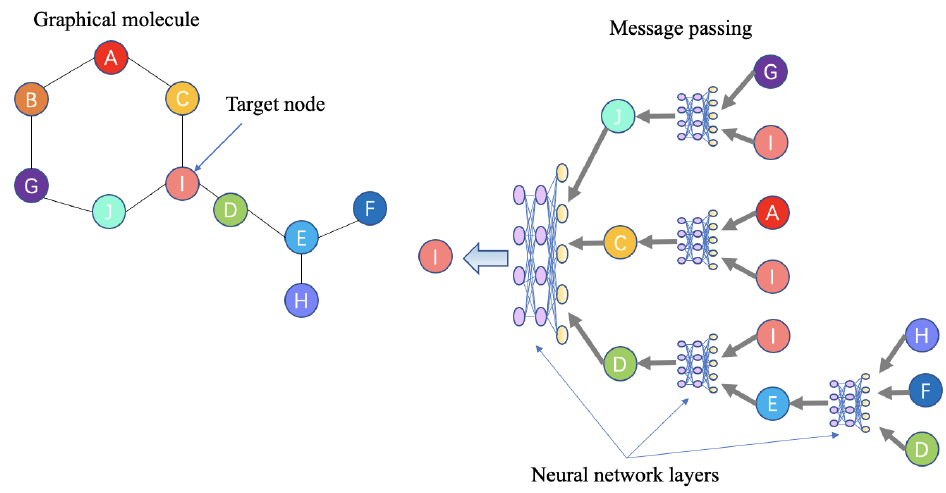
Figure 4. Example of a message passing neural network. The left side is an example of a graphical molecule. Ten atoms are regarded as nodes, with each node connecting with one or more nodes. The right side shows the message passing procedure for the target node I through a multilayer neural network (or one layer). The information from the directly connected nodes J, C, and D is passed to the target node I. As nodes J, C, and D have their own directly connected nodes (G, I, A, E), message is also passed by each of their neural networks. Message passing between nodes in a graph is a circular iteration process.